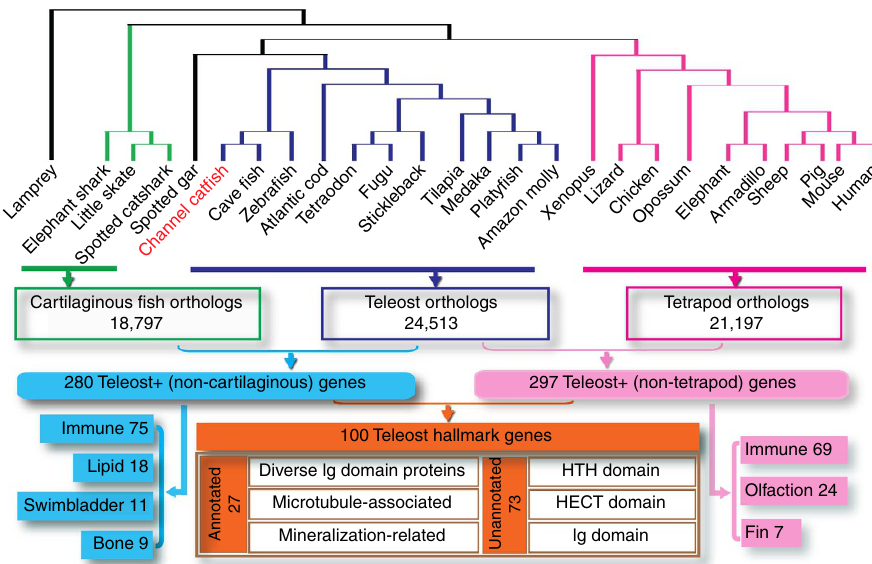
Figure 4 | Genomic hallmarks of teleosts. Shown on the top panel are species whose genome sequences were used for the analysis. On the lower panel, comparisons with cartilaginous fish are shown on the left, and comparisons with tetrapods are shown on the right. The genome hallmarks of teleosts are shown in the middle, highlighted by genes for diverse Ig domain-containing proteins, matrix mineralization and microtubule-associated